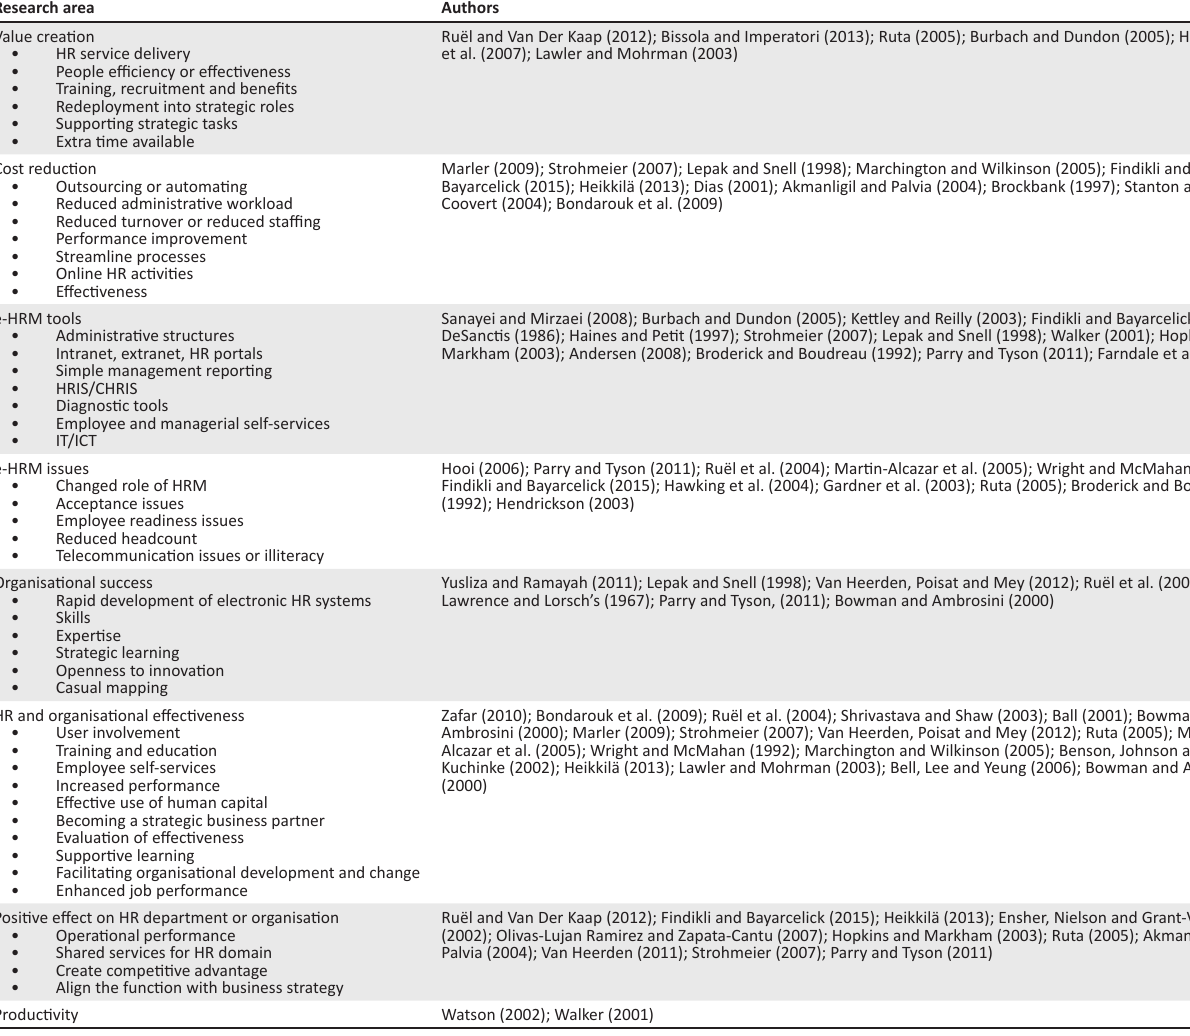
TABLE 1: Research areas to